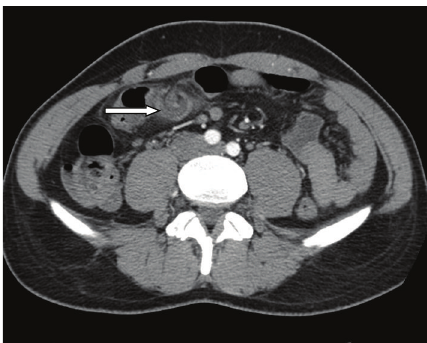
Figure 1: Axial contrast-enhanced CT scans obtained at the twisted point of omentum.